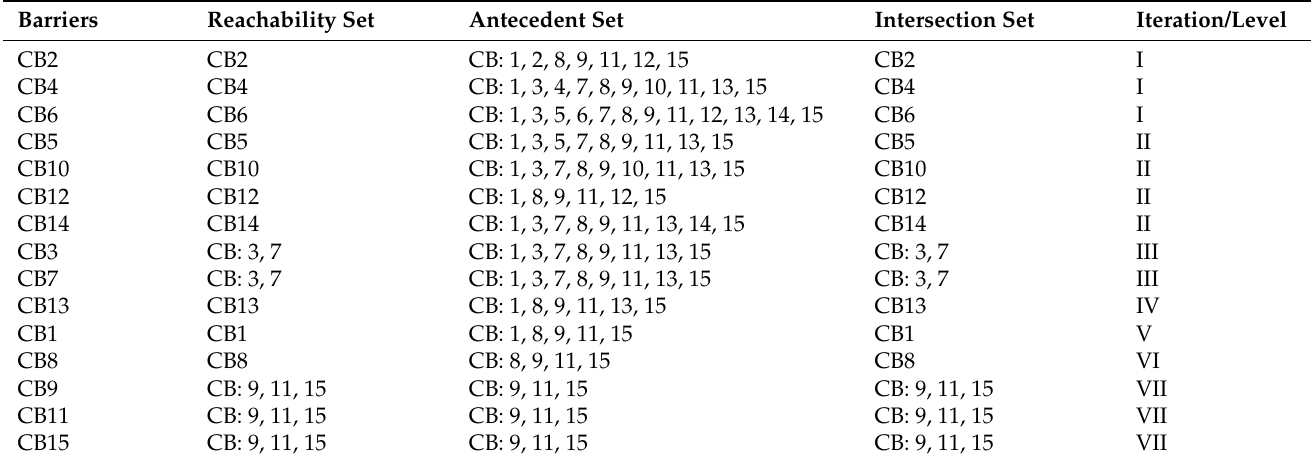
Table 7. Level partitioning.